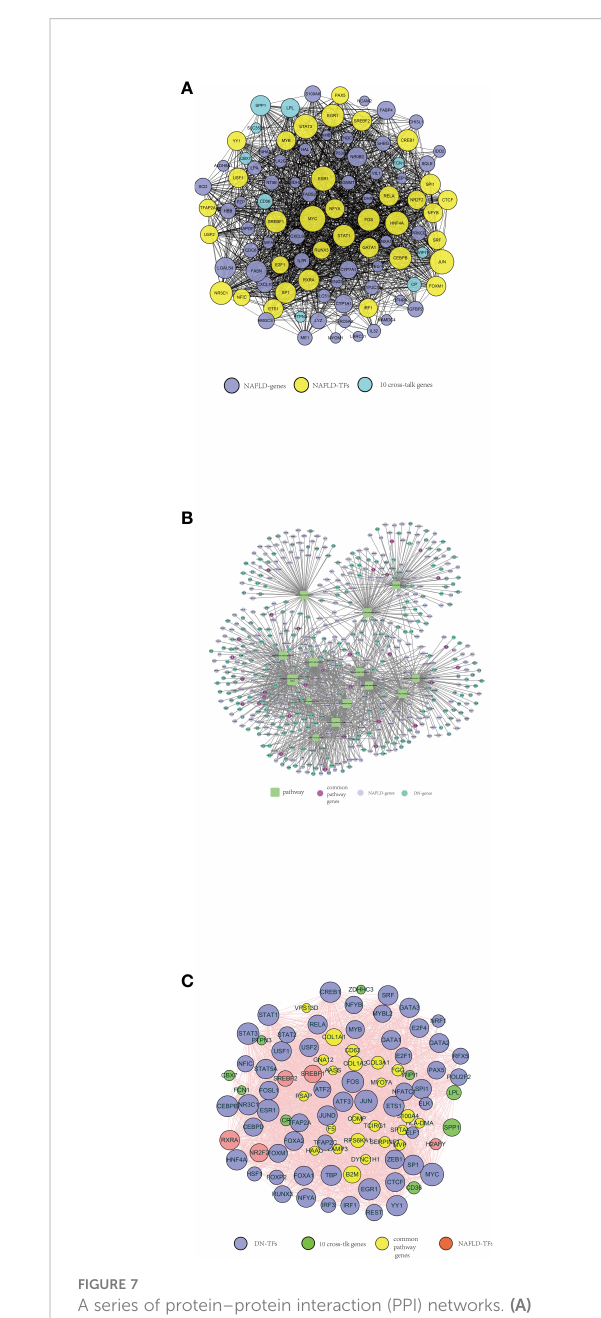
FIGURE 7 A series of protein – protein interaction (PPI) networks. (A) NAFLD-related TFs selected by TRRUST and ChEA3, indicated by yellow circles. The purple circles represent the top 50 signi fi cant differentially expressed genes in the NAFLD merged dataset. The optimal 10 crosstalk genes are indicated by the green circle. (B) Fourteen crucial pathways functioning in both NAFLD and DN, indicated by green squares. The purple-red circles represent the genes from each pathway both NAFLD-related and DN-related. The lilac circles represent the signi fi cant differentially expressed genes in the NAFLD merged dataset. The green circle represents the signi fi cant differentially expressed genes in the DN merged dataset. (C) DN-related TFs selected by TRRUST and ChEA3, indicated by purple circles. The green circles represent 10 optimal crosstalk genes. The genes from each pathway both NAFLD-related and DN-related were indicated by yellow circles. The pink circles represent NAFLD-related